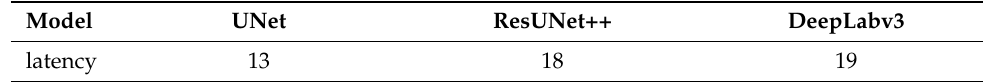
Table 8. The average time taken to segment a Ultrasound image.